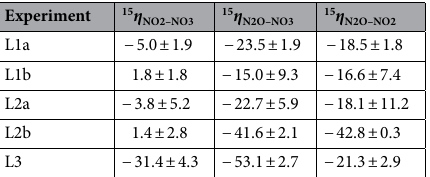
Table 1. Apparent isotopic fractionation factors for δ 15 N of NO 3− , NO 2− and N 2 O.